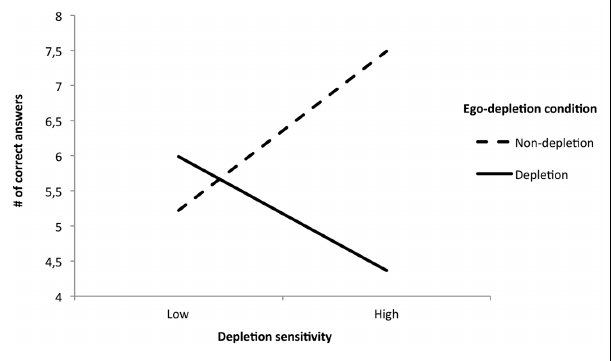
trait self-control and depletion sensitivity should not be viewed as completely unrelated as the correlations between these con- structs were moderate ( − 0.62 and − 0.43 in Studies 2 and 3). This finding indicates that, overall, people with more capacity to exert self-control are also less sensitive to depleting circum-